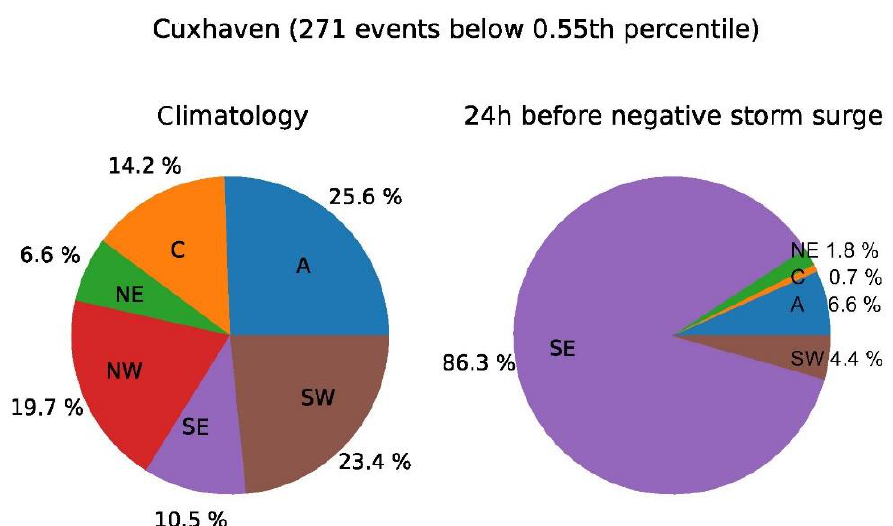
Figure 9. Left: Mean distribution of LWTs determined from daily means of ERA5 sea-level pressure for the entire period from 1950 to 2019. Right: Mean distribution of LWTs 24 h before ELW at Cuxhaven (Tnw below 0.55th percentile of all Tnw) between 1950 and 2019.